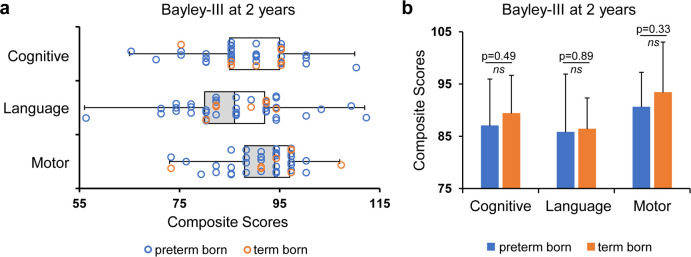
Bayley-III scores of the studied population.(a) Distribution of the Bayley-III cognitive, language, and motor composite scores of the studied population. (b) No significant differences in any of Bayley-III composite scores between preterm and term born infants.